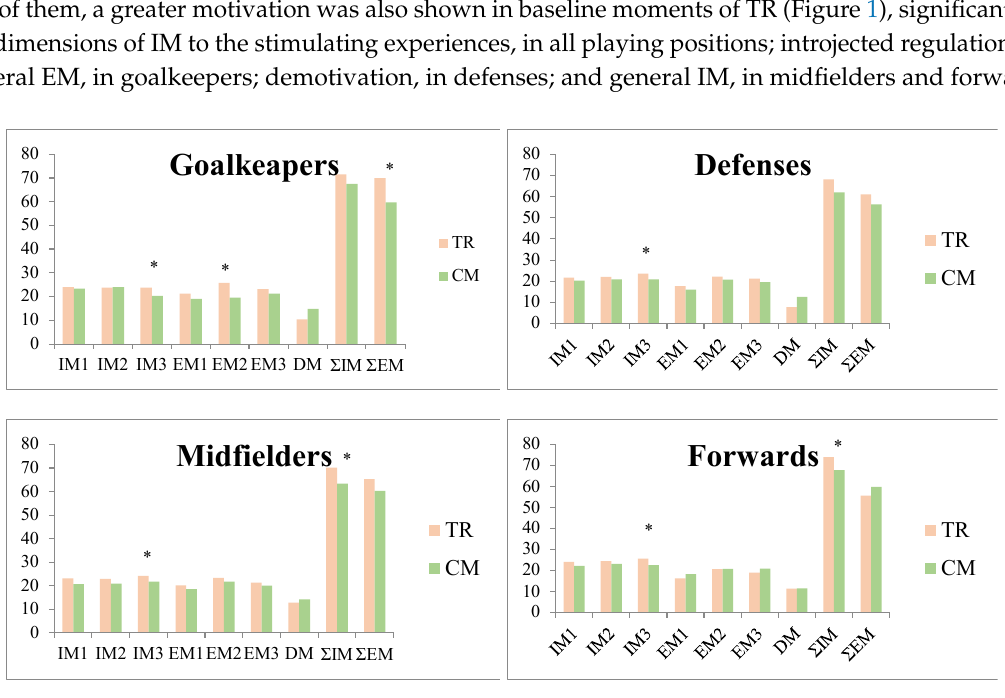
Figure 1. Paired t -test between baseline and precompetitive contexts of the motivation